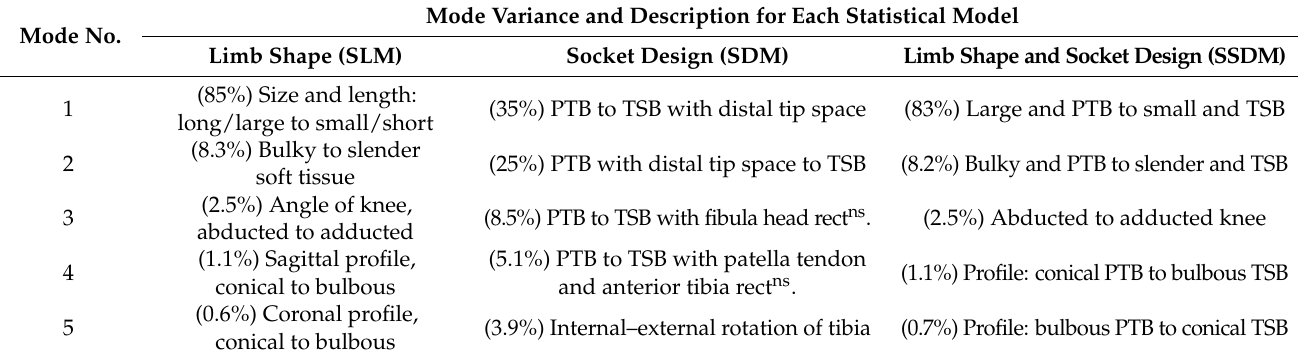
Table 1. Descriptions and proportional variance in shape and/or design described by the first five modes in each model. Mode